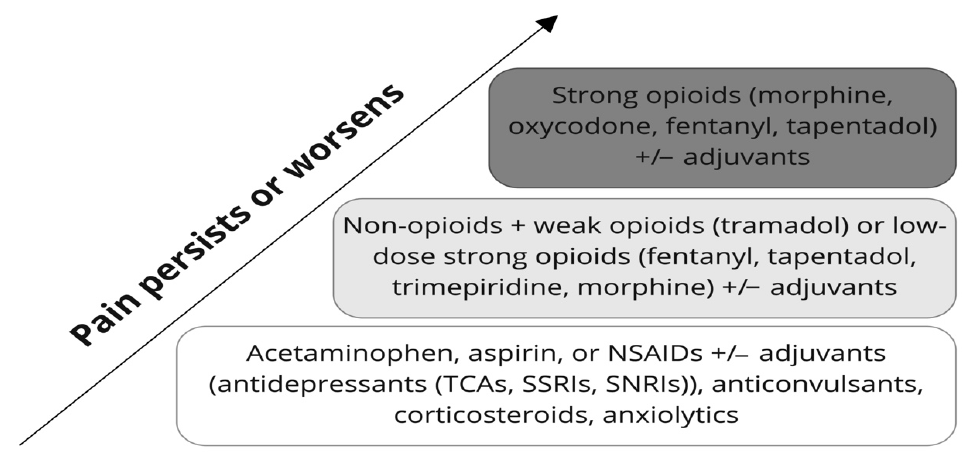
Figure 1. The WHO analgesic ladder. The “three step” concept of medication-assisted pain man- agement was originally developed by the WHO in 1986 for cancer-associated pain treatment but is now widely used in all areas of medicine. The three key principles of pain treatment according to the WHO are “by the clock, by the mouth, by the ladder”, which means regular and timely (“by the clock”) use of the safest and simplest forms (“by the mouth”) of the most effective and safest drugs, starting with less active non-opioid analgesics (with or without different adjuvants such as antidepressants (TCAs, SSRIs, SNRIs), anticonvulsants, corticosteroids, anxiolytics) with a gradual transition to more active opioid drugs with more adverse effects (“by the